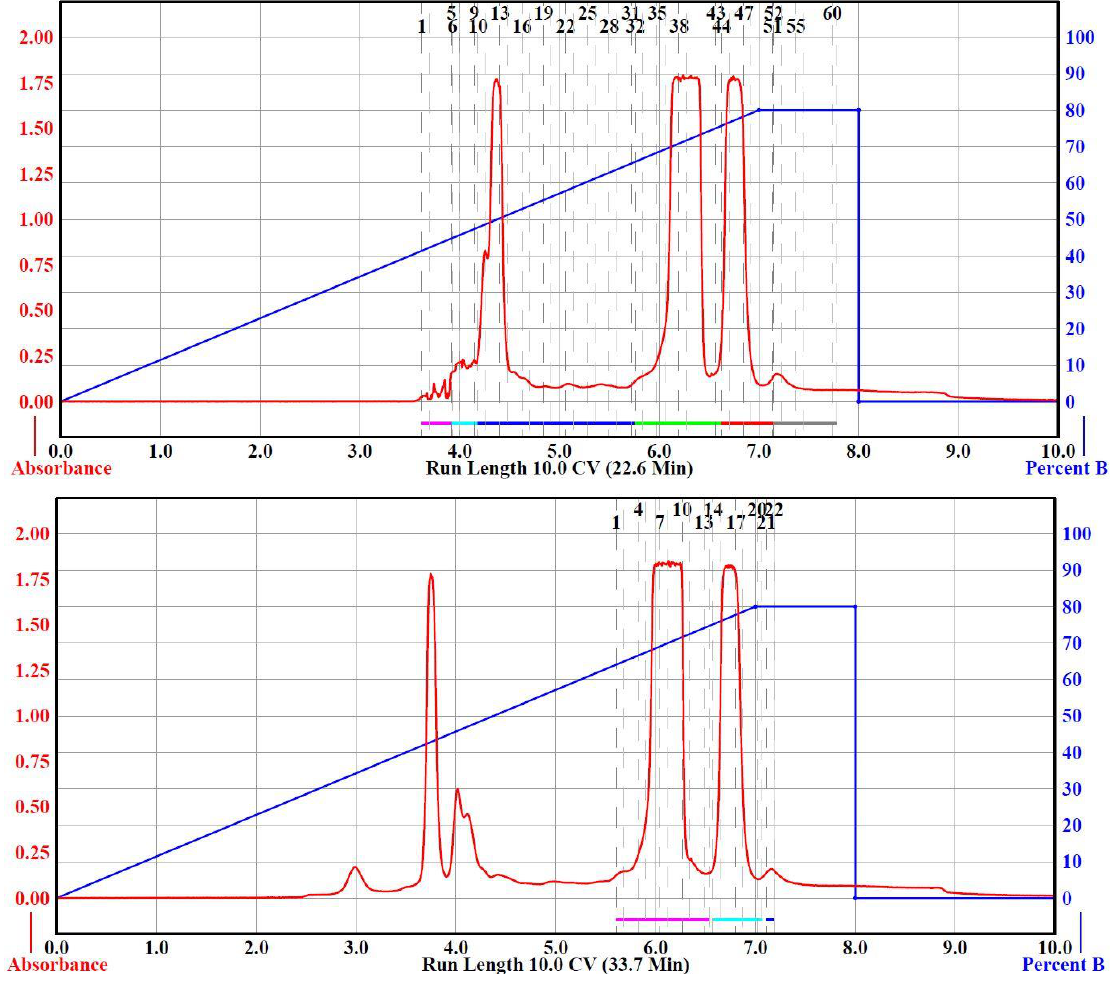
Figure 3. CombiFlash Rf200i flash chromatography Run 3 ( Top ) and Run 4 ( Bottom ) from Table 2. The solvent gradient of Percent B (acetone, right-blue axis) in hexane was denoted as the blue trace and the signal was monitored by UV detection (325 nm, left-red axis, red trace). Black numbers at the top of the chromatograms denote collection tube numbers.